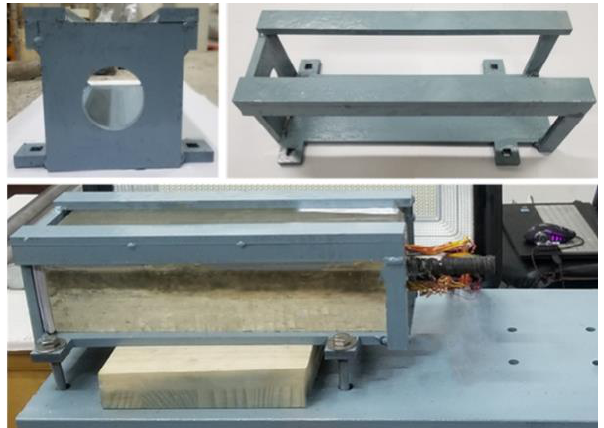
Figure 2. Anchorage support.